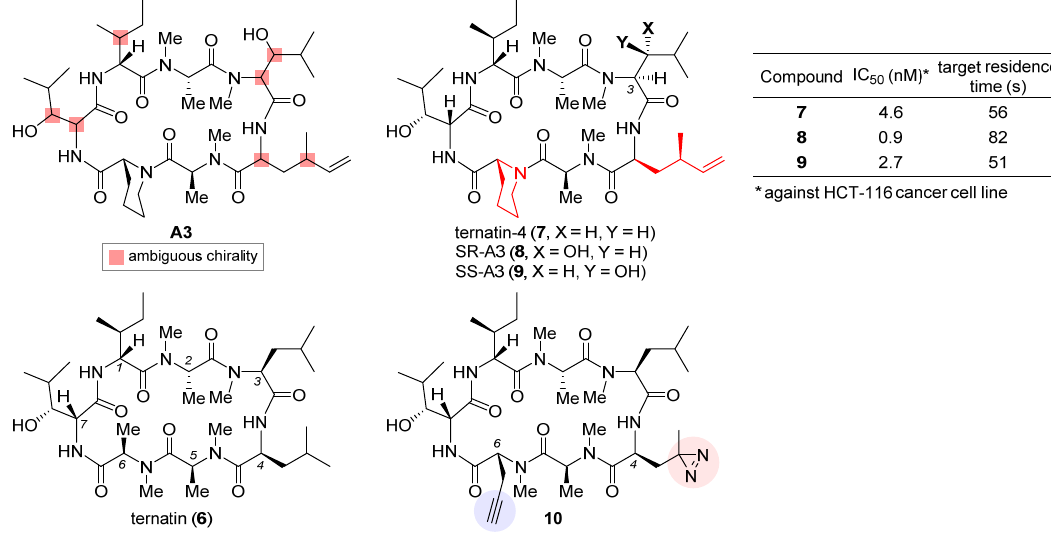
Figure 3. Structures of natural products A3 and ternatin ( 6 ), and synthetic analogues ternatin-4 ( 7 ), SR-A3 ( 8 ), SS-A3 ( 9 ), and photoaffinity probe 10 . The inset table compares anticancer activity and target residence time of 7–9 .